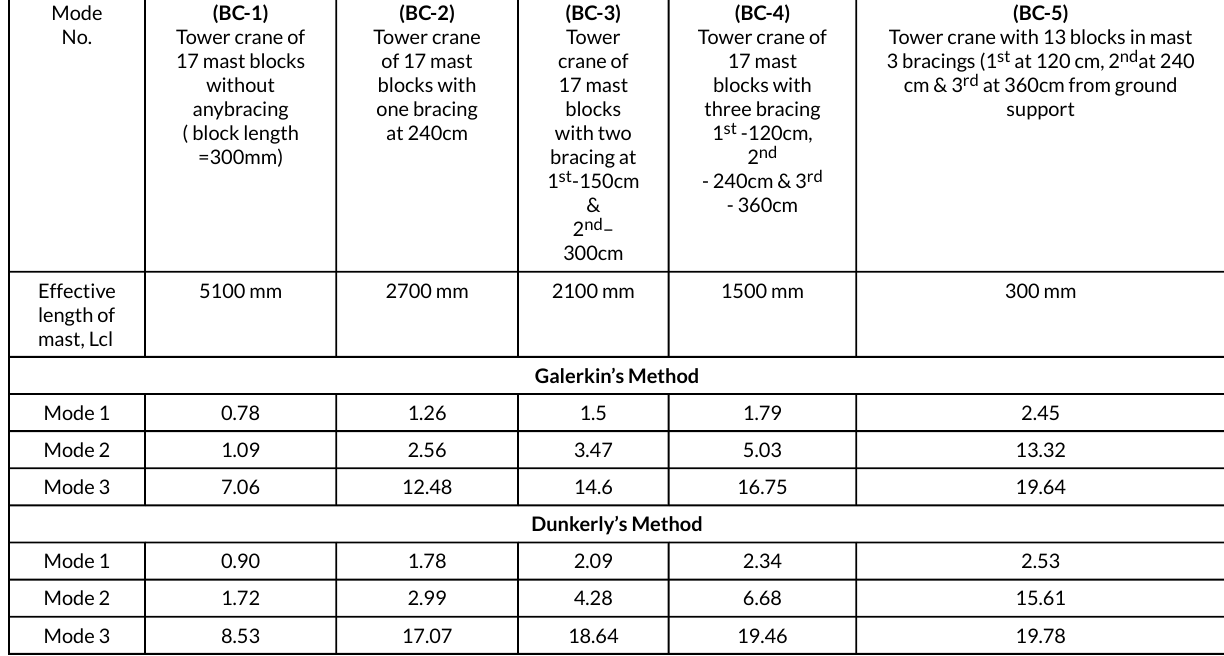
Table 1. Natural frequencies of tower crane under various boundary conditions in Hz Mode